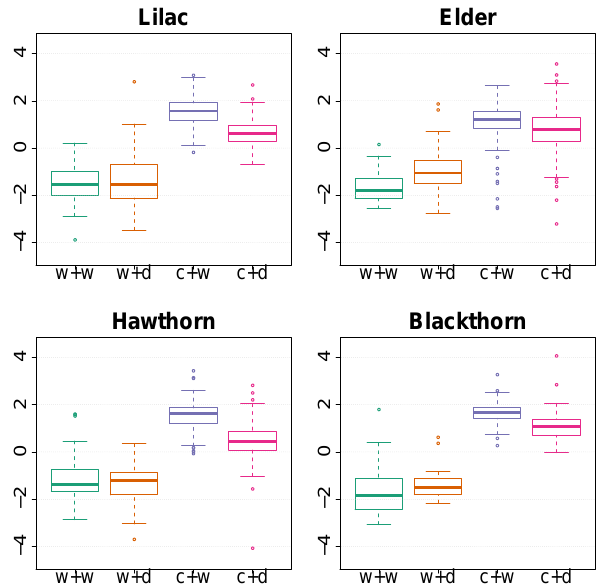
Figure 6. Distribution of flowering dates (standard box plots) for years that exhibit four different combinations of extreme meteo- rological conditions during early spring (w + w: warm and wet; w + d: warm and dry; c + w: cold and wet; c + d: cold and dry).